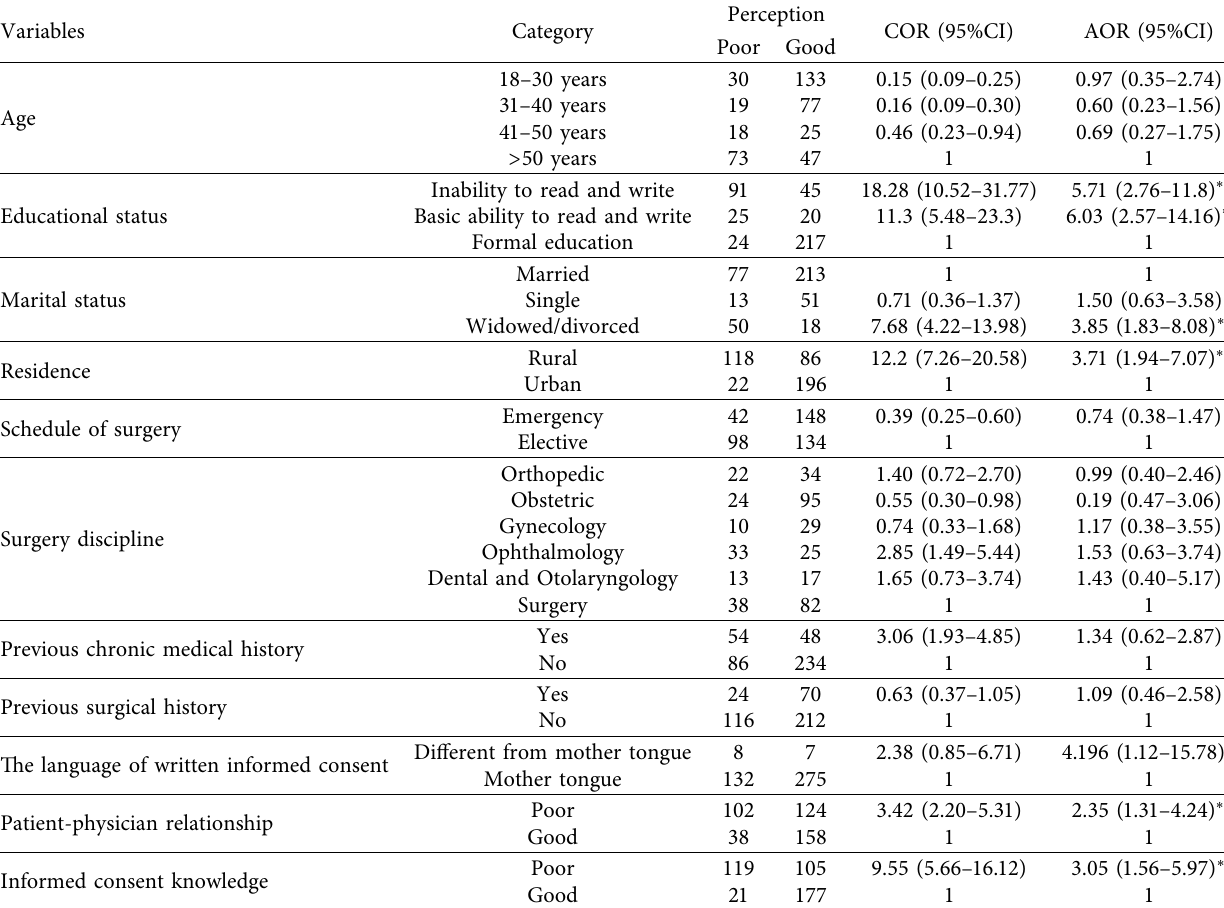
Table 6: Factors associated with perception of informed consent for surgical procedures among surgical patients in Dessie City Ad- ministration public hospitals, Northeast Ethiopia, 2021 ( N �